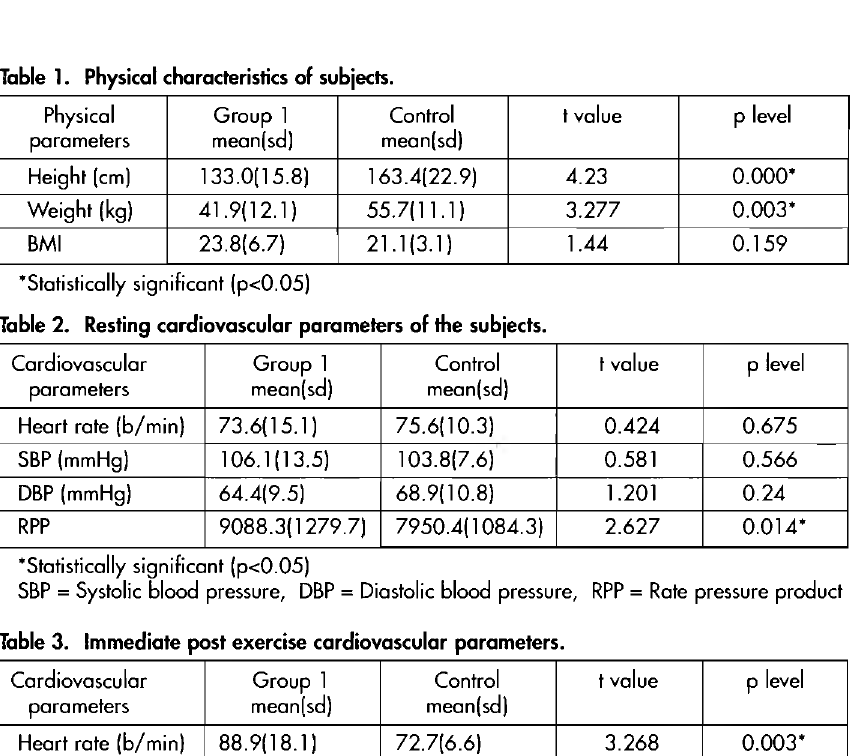
Table 1. Physical characteristics of subjects.